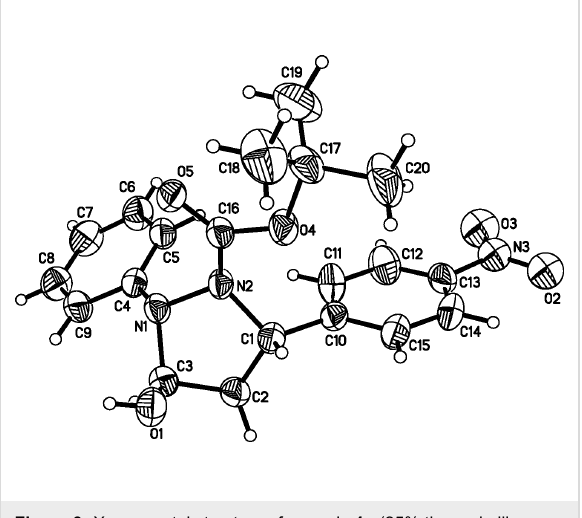
Figure 3: X-ray crystal structure of racemic 4n (25% thermal ellip- Table 3: Chiral-amine-catalyzed cascade aza-Michael/hemiacetal reaction of 2c with 3a .